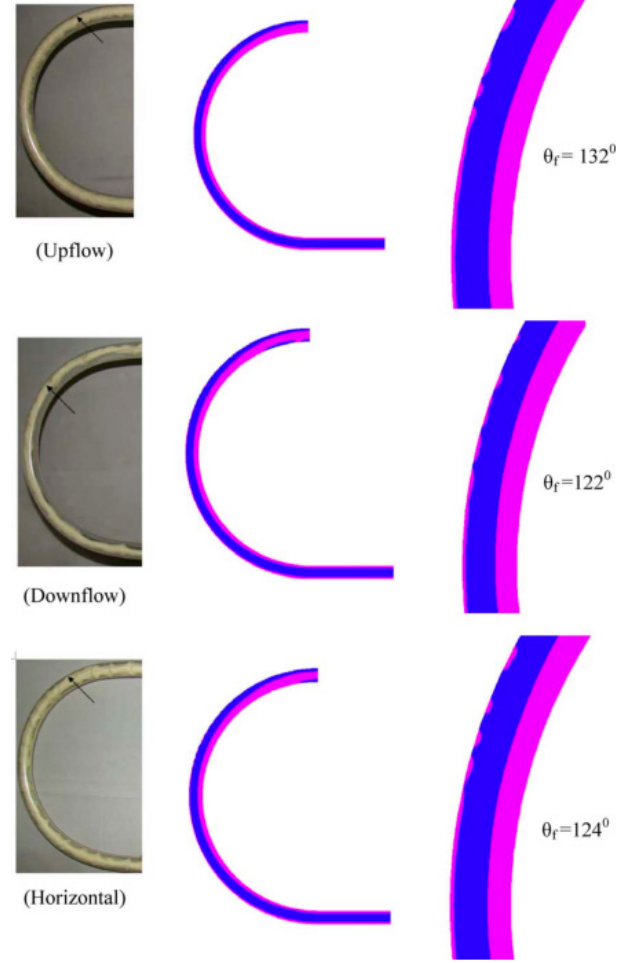
Figure 19. Oil fouling to the wall in the U-shaped bend [62]. ( θ f is an angle describing the initial point of the fouling. Blue for oil and magenta for water.)